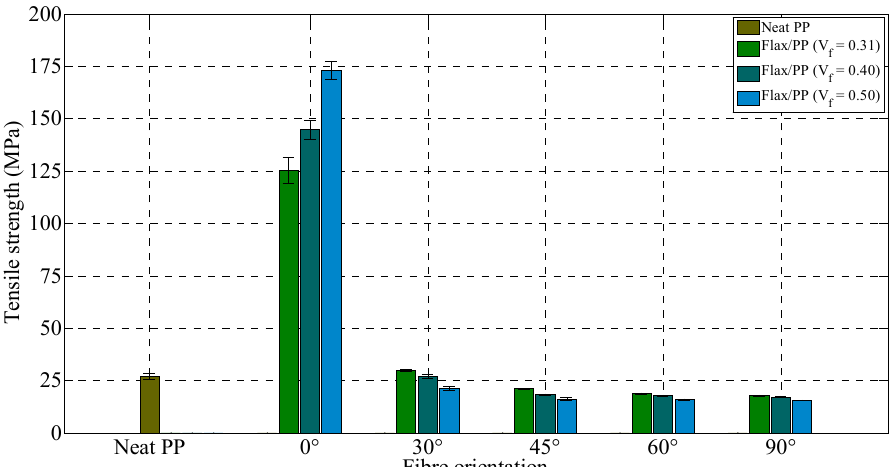
Figure 13. Tensile strength for neat PP and flax/PP samples of different fibre volume fractions and orientations.